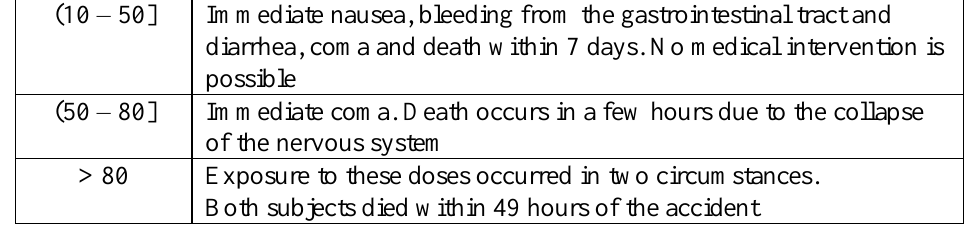
Table 1: Effects of radiation on human beings